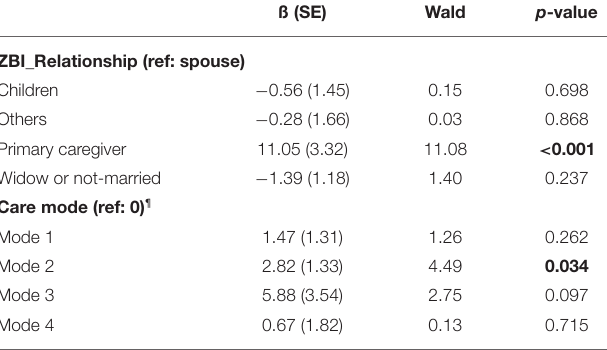
TABLE 3 | Generalized estimating equations to determine factors associated with caregiver